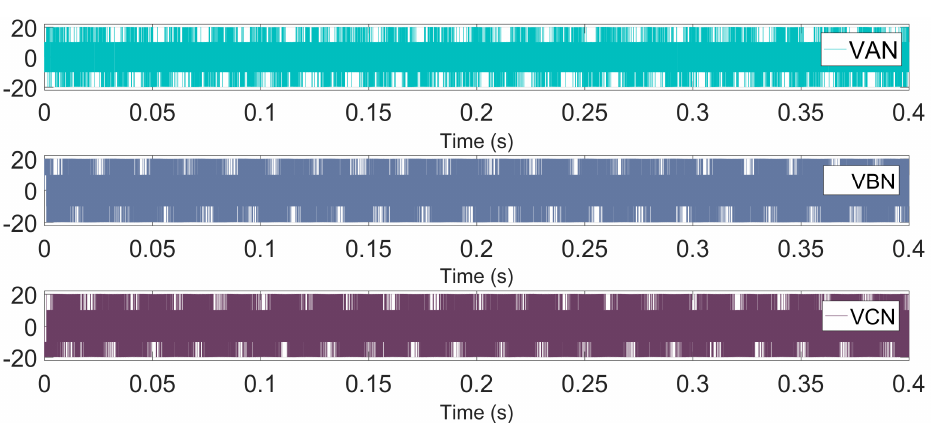
Figure 10. The output voltage (phase-neutral) waveform of the FS-PDCC controlled three-phase VSI for T s = 20 μs.